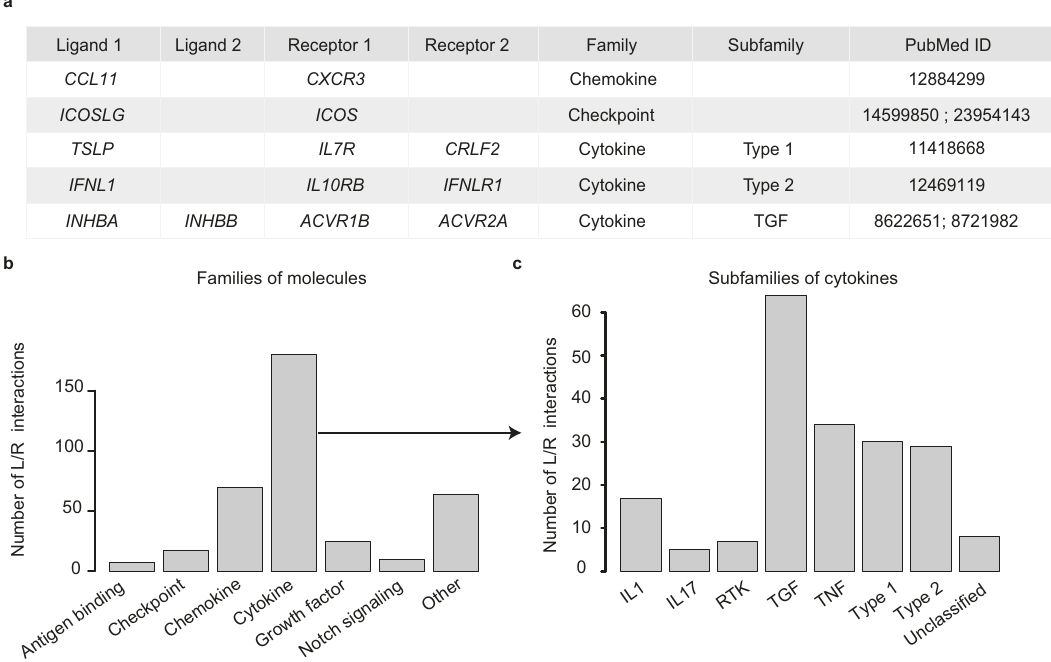
Fig. 1 Structure of the ligand – receptor database. a Extract of the ligand – receptor database. The database is structured as the following scheme: the 4 fi rst columns correspond to gene symbol of each subunit of interacting ligand and receptor, the next two columns state the classi fi cation into families and/or subfamilies of molecules, and the last column gives the source for manual curation (PubMed ID). b Histogram displaying the number of interactions classi fi ed in each family of communication molecules included in the database (antigen binding, checkpoint, chemokine, cytokine, growth factor, notch signaling). c Histogram displaying the number of interactions classi fi ed in the different de fi ned subfamilies of cytokines: interleukin 1 family, interleukin 17 family, receptor tyrosine kinase (RTK) family, transforming growth factor beta (TGF) family, tumor necrosis factor family (TNF), type 1 cytokine family, and type 2 cytokine family, and unclassi fi ed